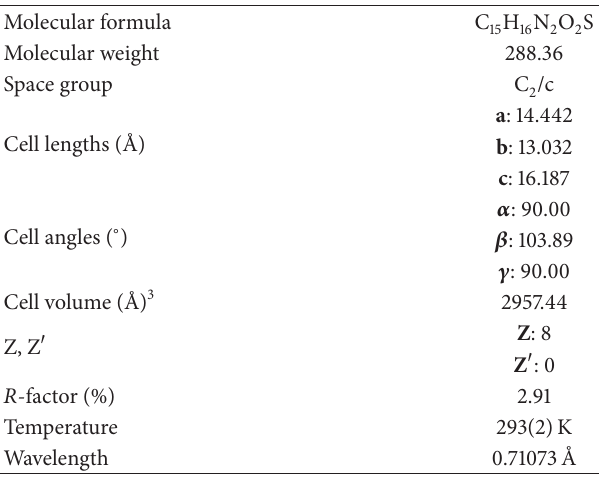
Table 1: Crystal data and details of the structure refinement of